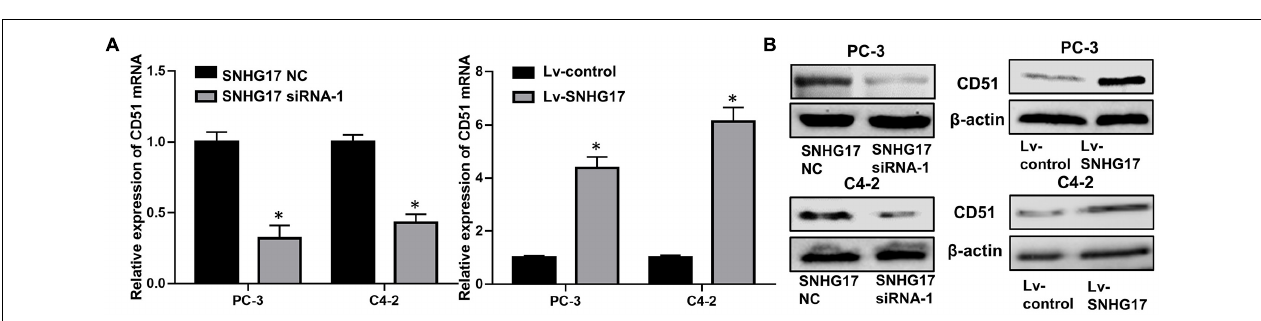
FIGURE 4 | CD51 expression was up-regulated by SNHG17. (A) The effects of SNHG17 on the mRNA levels of CD51, as detected by RT-QPCR; (B) The effects of SNHG17 on the mRNA levels of CD51, as detected by WB; Data are expressed as the mean ± S.E . * P < 0.05, ns, not significant. The representative results of three independent experiments are